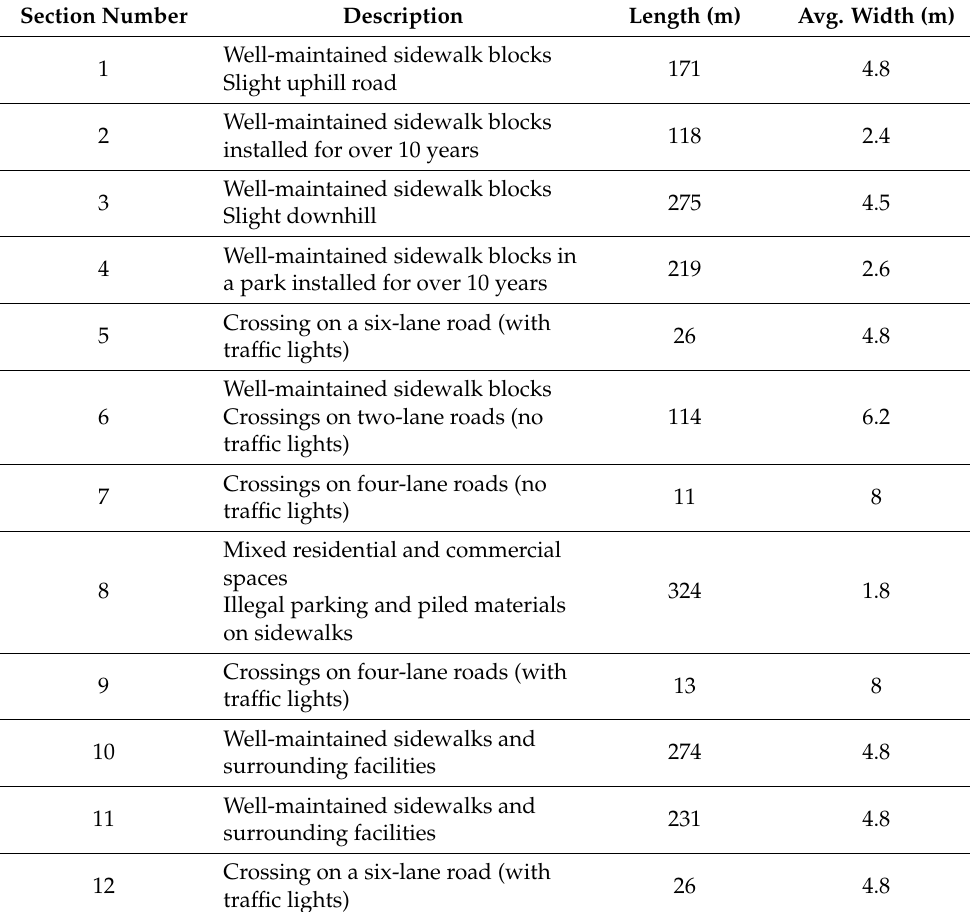
Table 1. Summary of characteristics of each section.